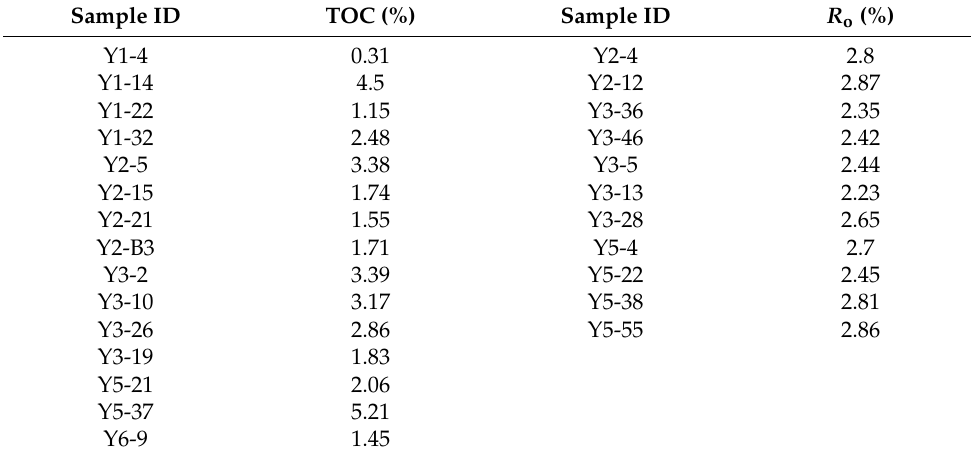
Table 1. The organic geochemical characteristics of shale samples. TOC: total organic carbon.